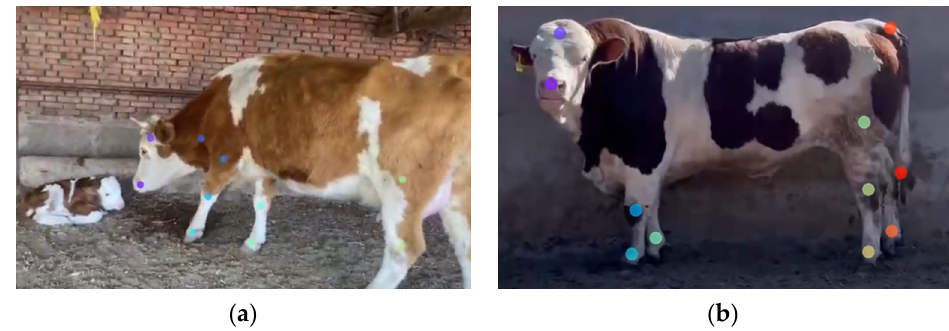
Figure 5. Tracking results of key cow body parts in different postures: ( a ) cows walking; ( b ) dairy cows standing. Cow protective behavior is correlated with the posture of their own movements. The protective behavior in different postures also affects the tracking of the feature points. Distinguishing between normal movement behavior and protective behavior requires using the transient characteristics of protective behavior for identification.